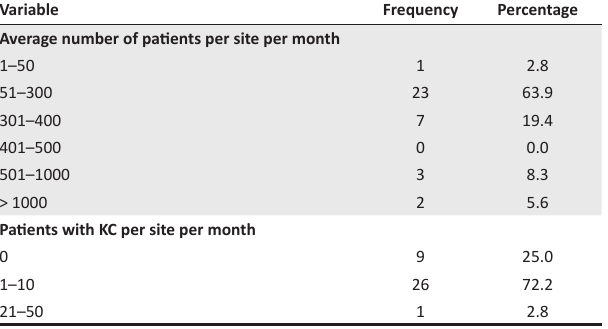
TABLE 2: Number of total patients and keratoconic patients per site monthly. Variable